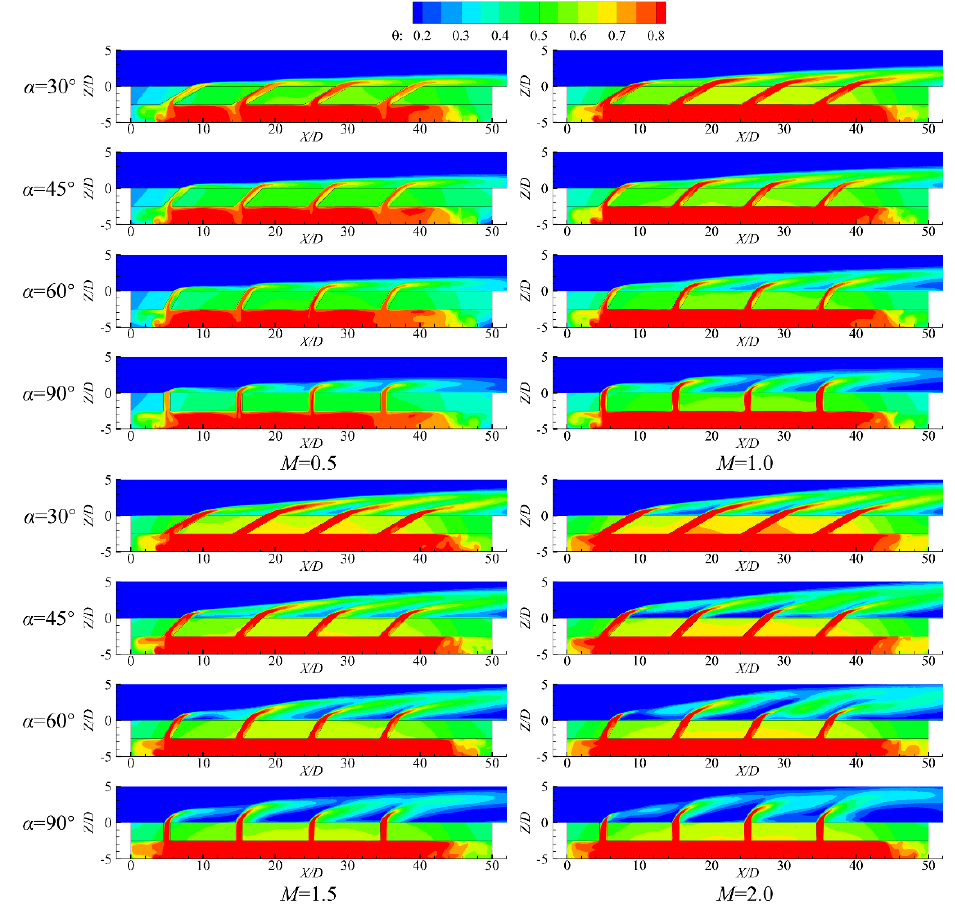
Figure 8. Contours of non-dimensional temperature at Y = 0 plane for fluid and solid domains.